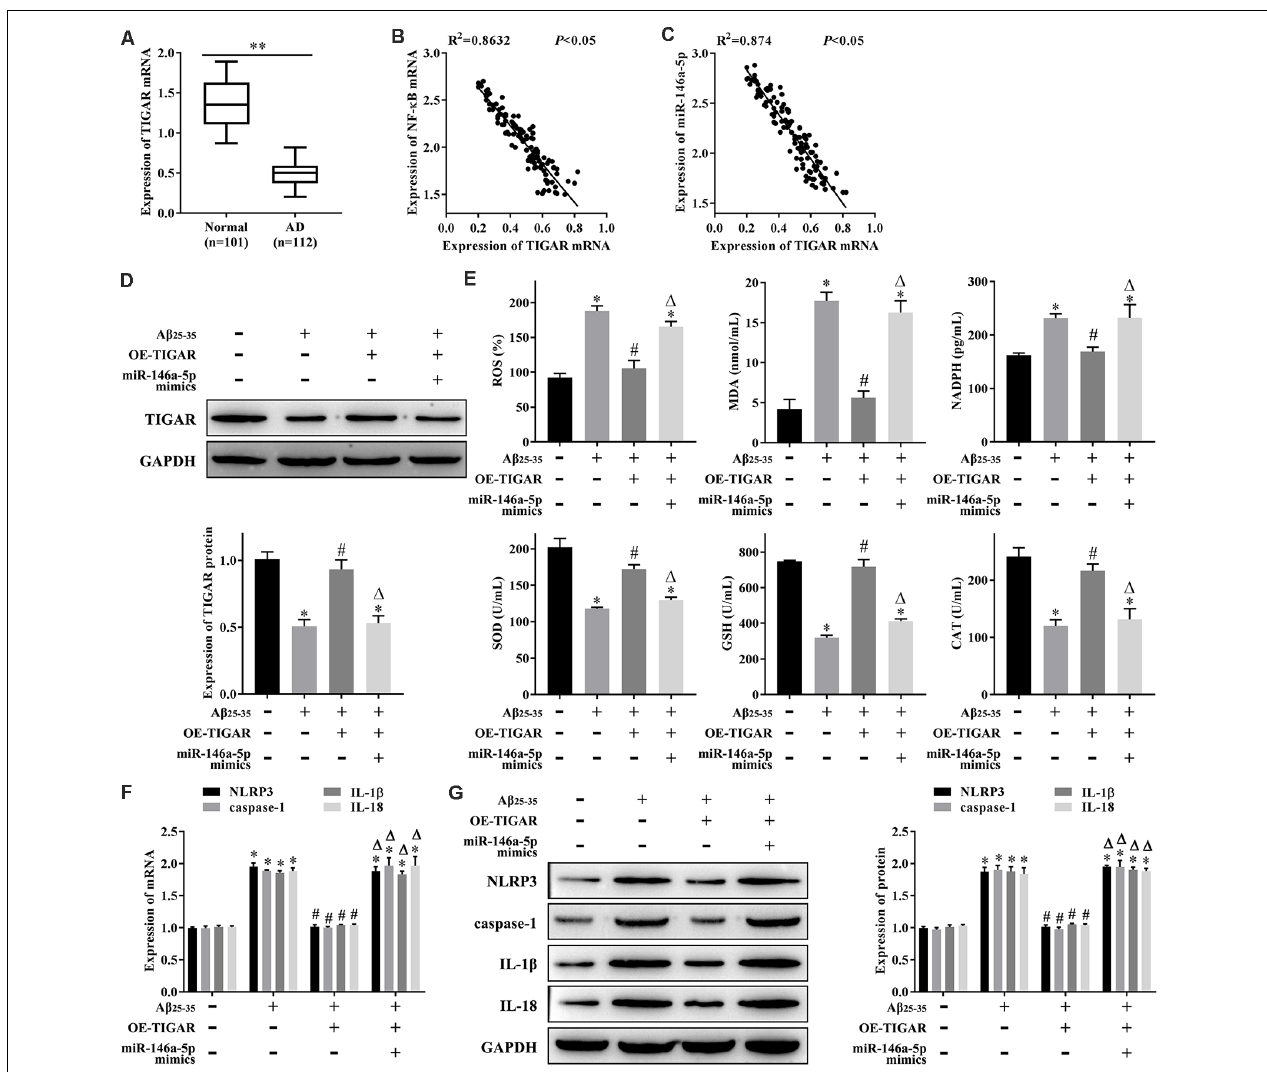
FIGURE 4 | miR-146a-5p regulates oxidative stress and pyroptosis in a cell culture model of Alzheimer’s disease in human hippocampal neurons (AD-HNNs) via TIGAR. (A) Relative expression level of TIGAR mRNA. ∗∗ P < 0.01 vs. normal group. (B) Linear analysis between NF- κ B mRNA and TIGAR mRNA. (C) Linear analysis between miR-146a-5p and TIGAR mRNA. (D) Protein expression of TIGAR. (E) Level of oxidative stress indices (ROS, MDA, NADPH, SOD, GSH, and CAT). (F) mRNA expression of pyroptosis markers (NLRP3, caspase-1, IL-1 β , and IL-18). (G) Protein expression of pyroptosis markers (NLRP3, caspase-1, IL-1 β , and IL-18). ∗ P < 0.05 vs. HHN group; # P < 0.05 vs. AD-HHN group; ∆ P < 0.05 vs. AD-HHN+OE-TIGAR